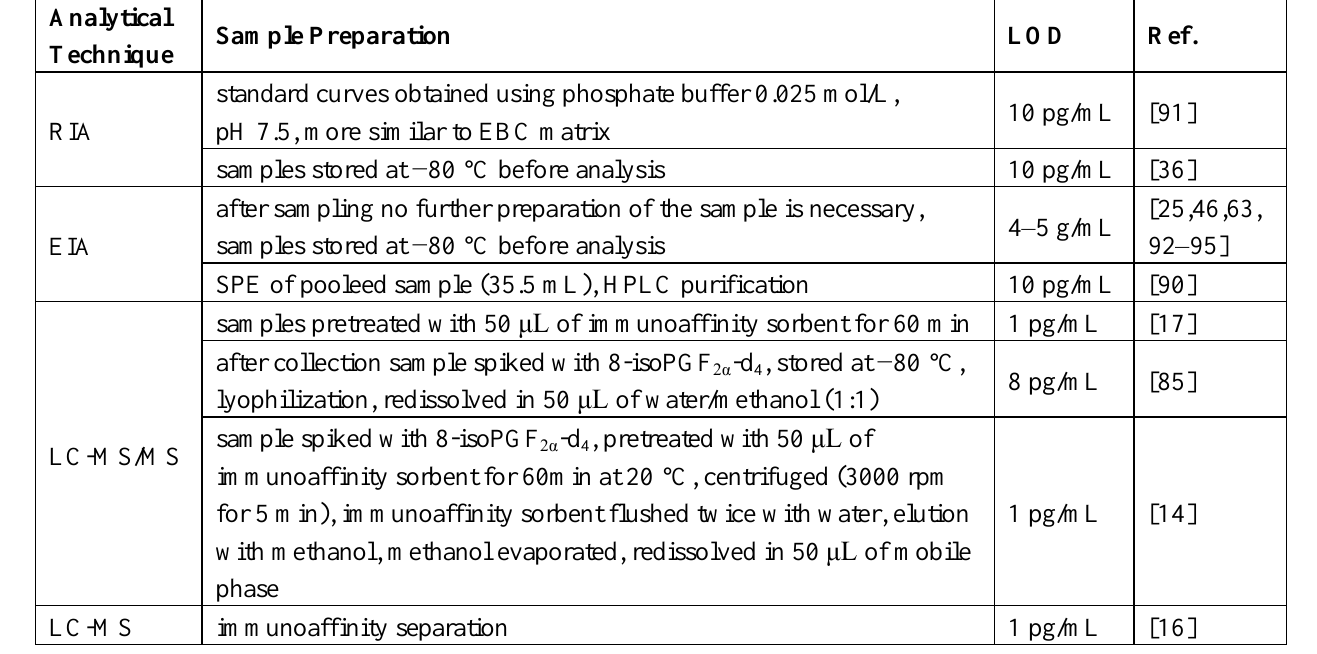
Table 2. Examples of sample preparation procedures for EBC samples with different final analysis